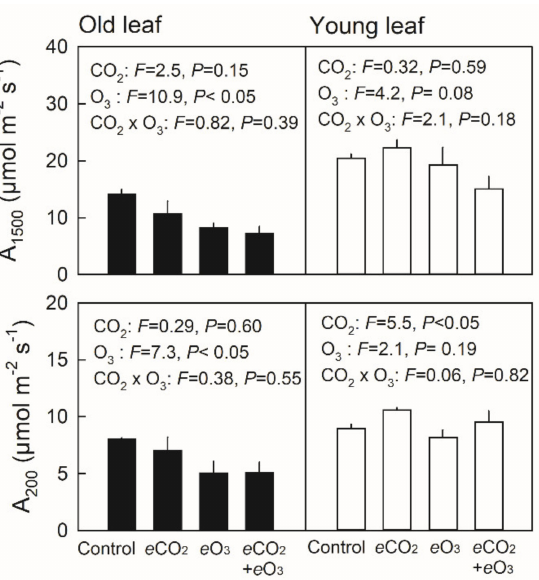
Figure 3. Net photosynthetic rate under saturating (upper panel) or limiting light intensity (lower panel) in old (closed bar) and young leaves (open bar) of Japanese white birch seedlings grown under the CO 2 and O 3 treatment combinations. Control—ambient air, eCO 2 —elevated CO 2 , eO 3 —elevated O 3 , and eCO 2 + eO 3 —elevated CO 2 and O 3 . Young leaves were ≈ 30 days old, and old leaves were ≈ 60 days old. Measurements were conducted under the respective growth CO 2 concentrations, where a CO 2 concentration of 380 µ mol mol − 1 was applied for control and eO 3 plants, and that of 550 µ mol mol − 1 was applied for eCO 2 and eCO 2 + eO 3 plants. F -value and probability ( P ) of the effects of CO 2 , O 3 and their interaction are indicated in the panel. Values are mean + SE (n =